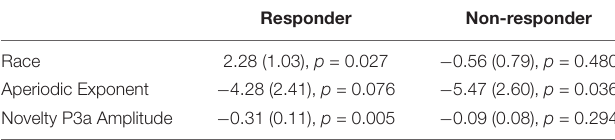
TABLE 2 | Multinomial logistic regression predicting methylphenidate